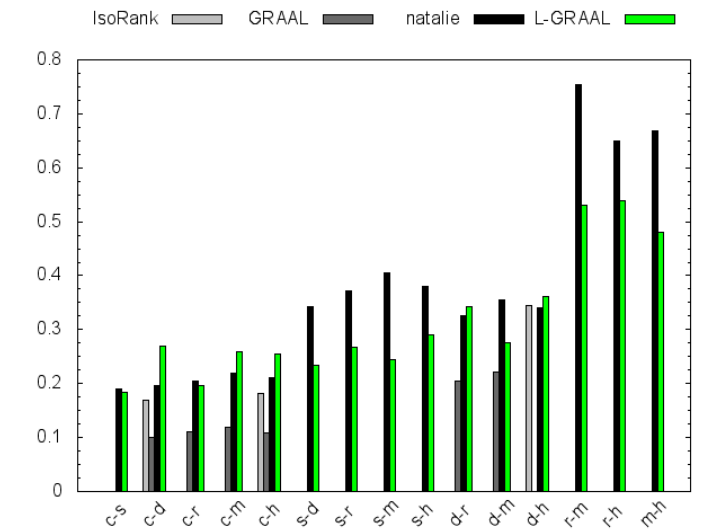
Figure 3. Biological relevance of the alignments measured via GO